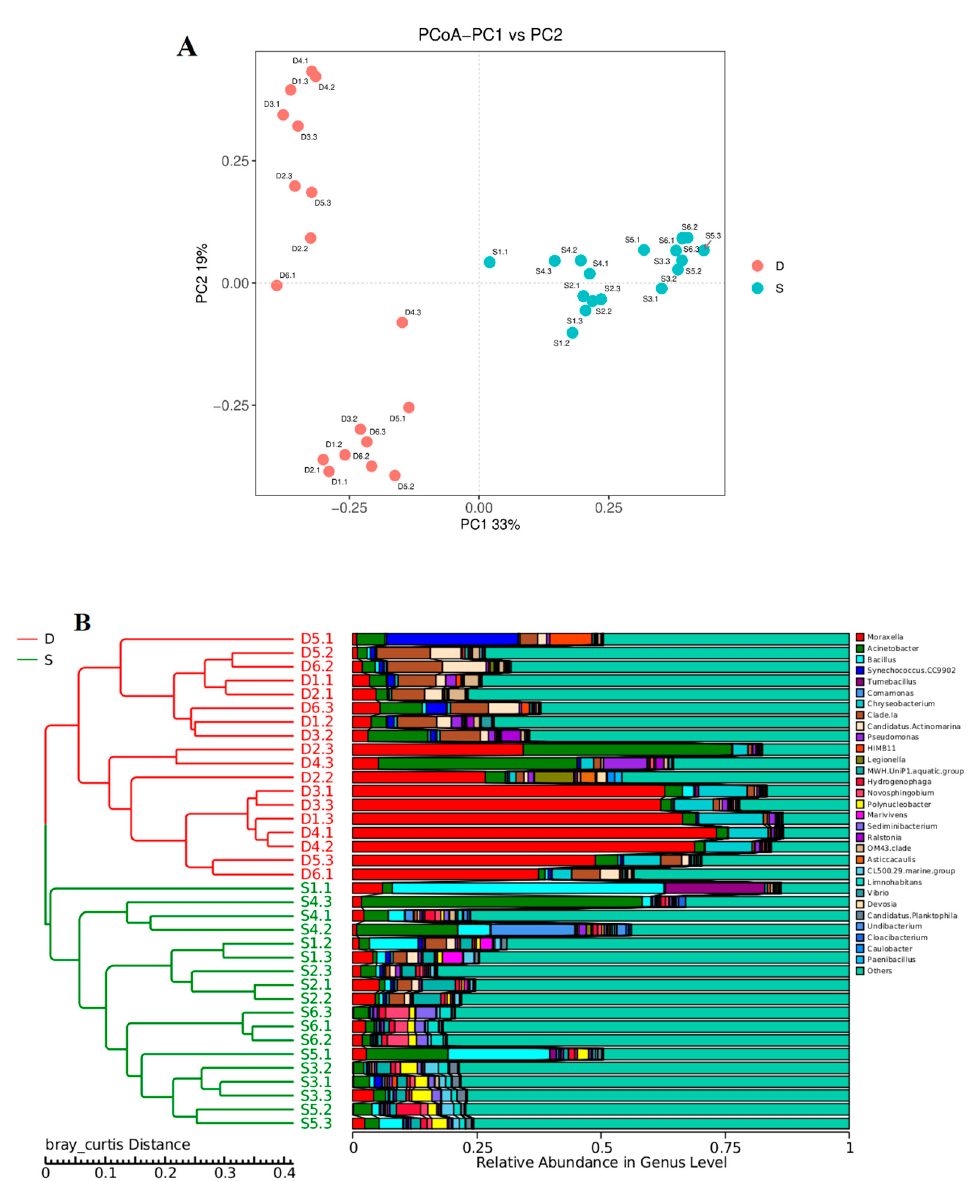
Figure 3. ( A ) Principal coordinates analysis (PCoA) of the bacterial communities in the samples. PC 1 and 2 accounted for 33% and 19% of the variance, respectively. ( B ) Dendrogram from the cluster analysis of the relationship between bacterial communities in coastal area S and D. Table 2. ANOSIM analysis of bacterial compositions in different groups.